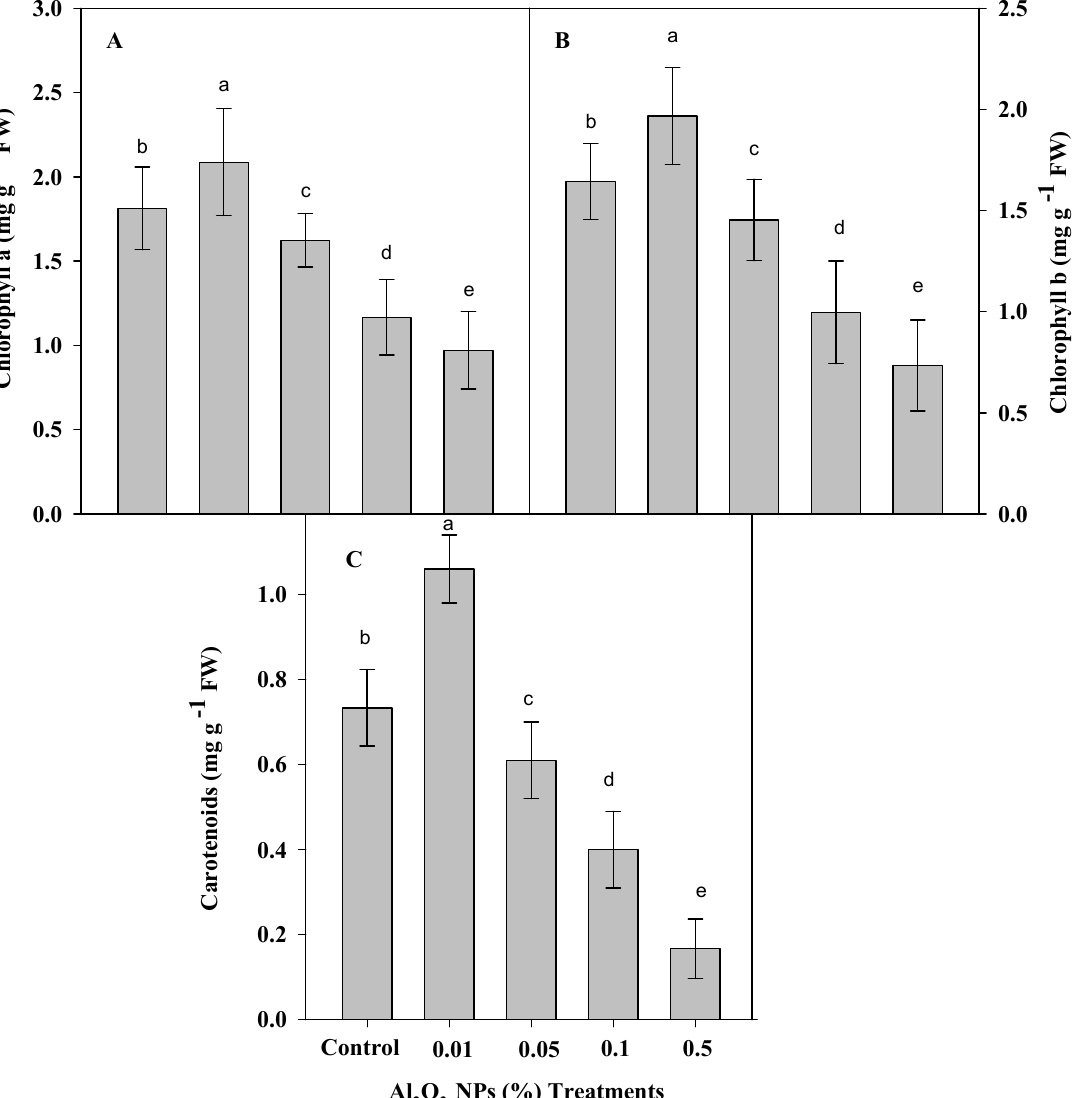
Figure 3. E ff ects of seed-priming with aluminum nanoparticles (Al 2 O 3 NPs) on ( A ) chlorophyll a,